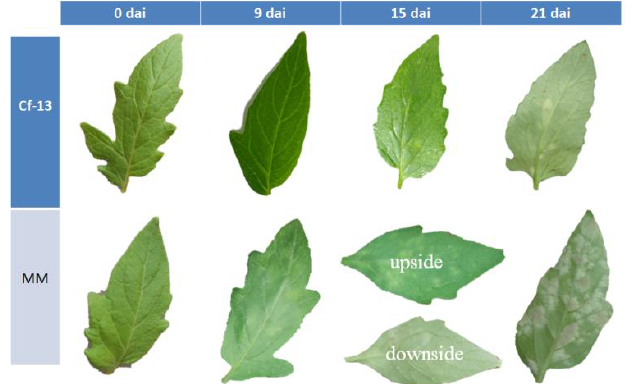
Figure 1. C. fulvum infection symptoms on the leaves of MM and Cf-13 plants. MM: Moneymaker; Cf-13 : Ont7813; dai: days after inoculation. The infection processes of C. fulvum in the leaves of Ont7813 and MM were observed